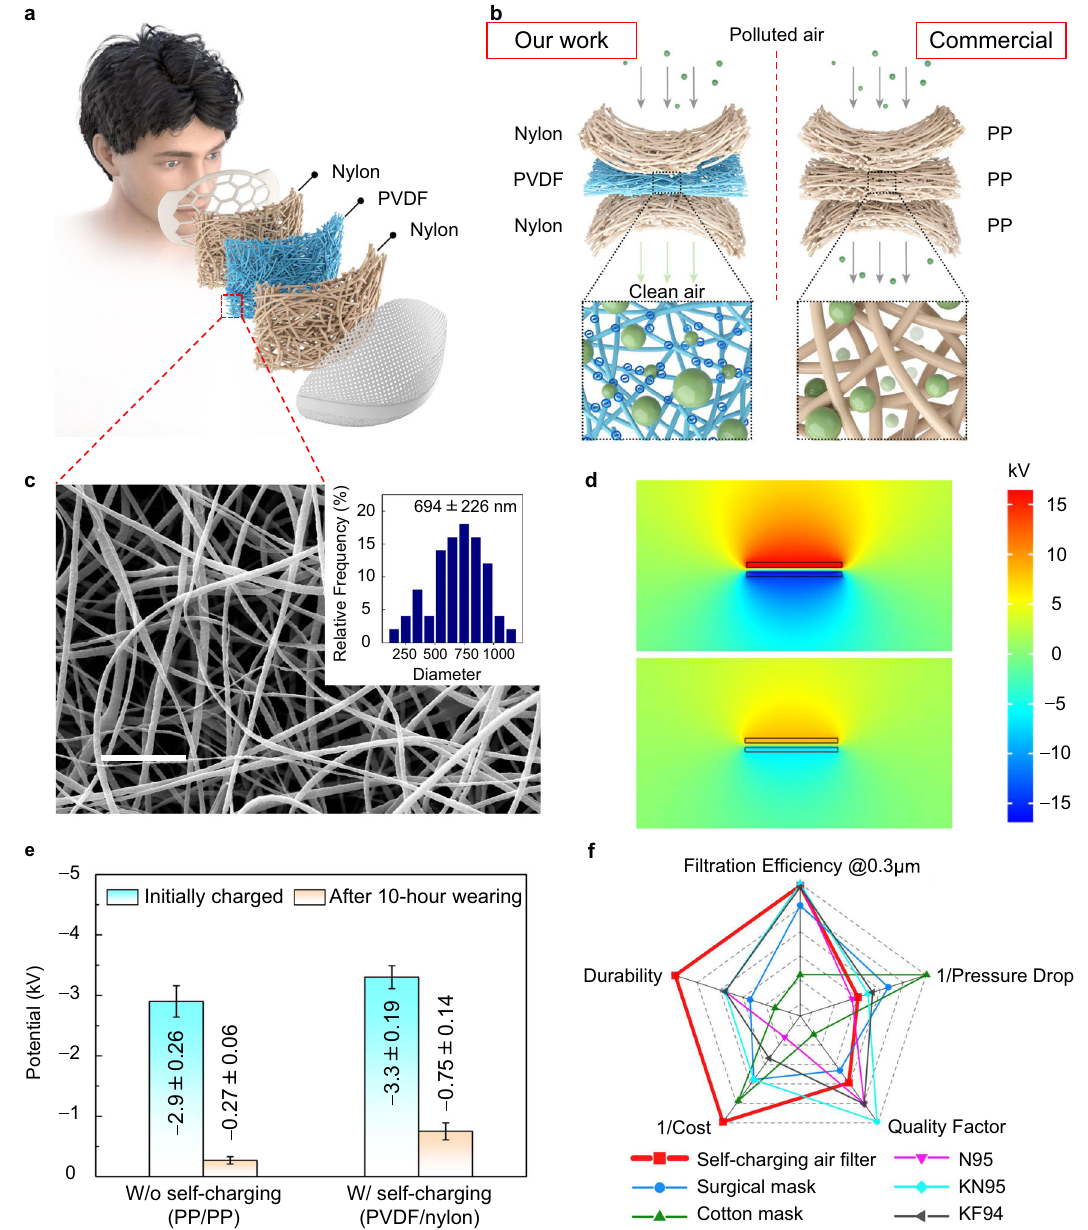
Fig. 1 | A self-charging air- fi ltering mask with prolonged electrostatic adsorp- tion. a Schematic diagram of the proposed self-charging air- fi ltering mask. b Enhanced particle capture capacity with the PVDF/nylon pair (left) employed in the SAF compared with the PP/PP (or PP/PE) pair (right) in a surgical mask. The zoomed-in illustrations indicate the ef fi cient electrostatic adsorption for fi ne par- ticles with the SAF design. c Microscopic morphology of the electrospun PVDF nano fi ber fi lter medium. Scale bars: 10 μ m. Inset: fi ber diameter distribution. d COMSOL simulation results comparing the potential distribution pro fi le of the PVDF/nylonpair(top)andPP/PEpair(bottom). e Electrostaticpotentialattenuation